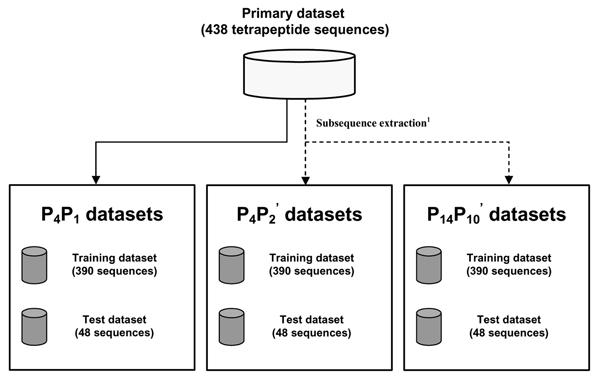
Schematic layout of the datasets used for SVM training and testing. The primary dataset consist of non-redundant tetrapeptide caspase substrate cleavage sites obtained from literature (see Additional File 1) and an equal number of non-cleavage sites. 1The P4P1 sequences consist of all the sequences in the primary tetrapeptide cleavage site dataset. P4P2' and P14 P10' datasets were derived by extracting subsequence segments from the parent protein chains in the vicinity of the tetrapeptide cleavage sites, as shown in Figure 1. All datasets contain equal number of positive and negative examples.